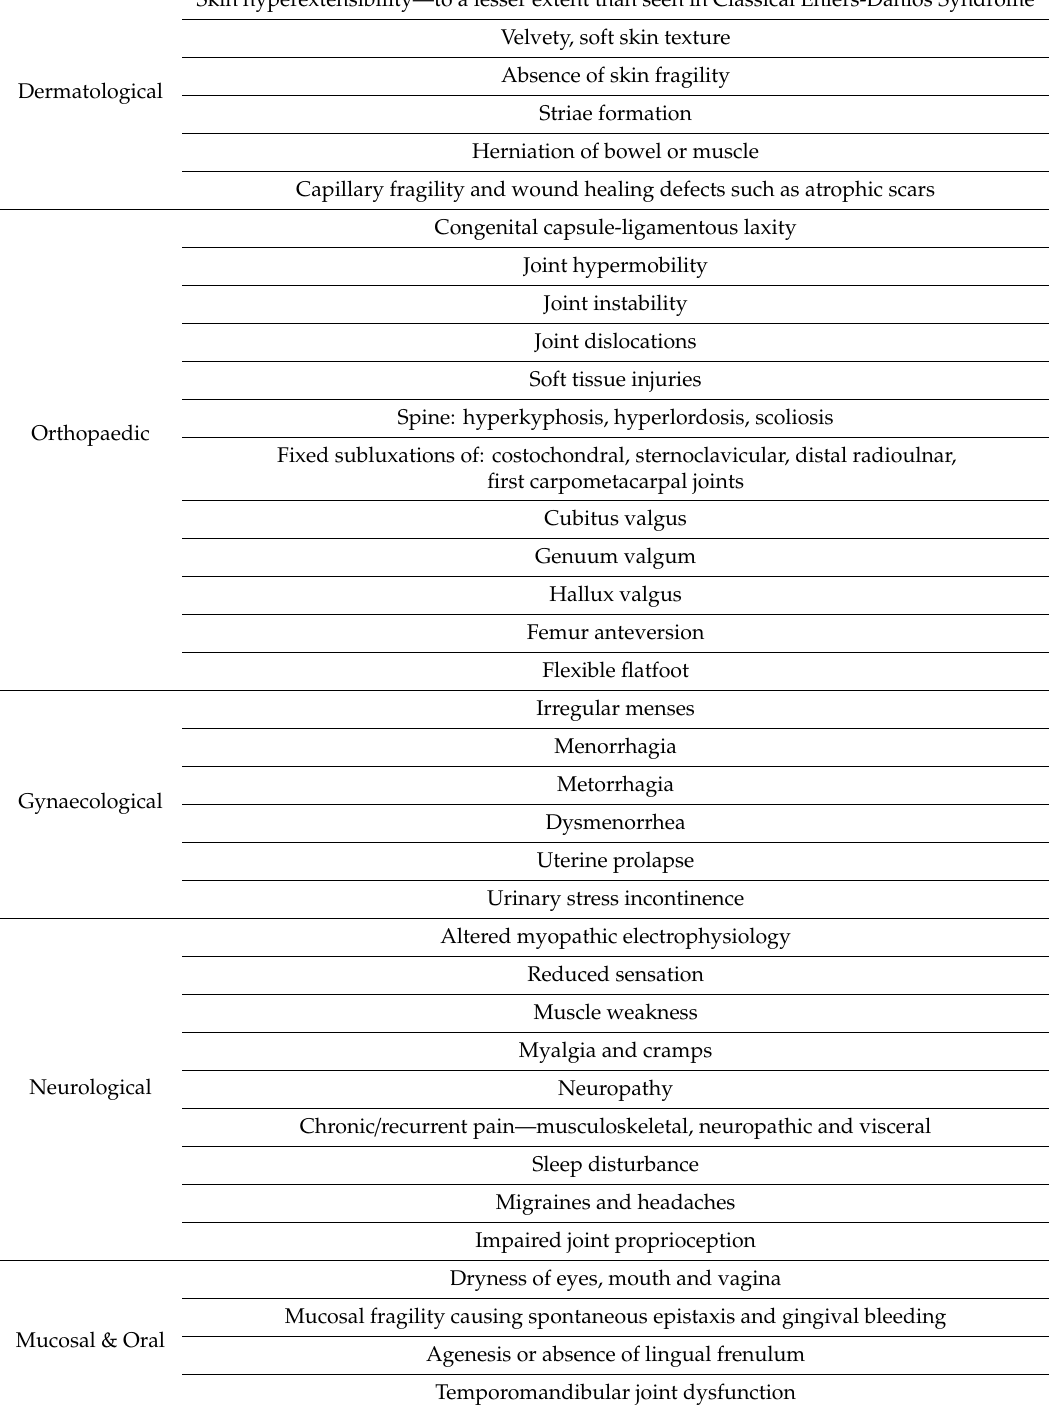
Table 5. Possible systemic features of hypermobility-type Ehlers-Danlos Syndrome and hypermobility spectrum disorders. Adapted from Castori, 2012